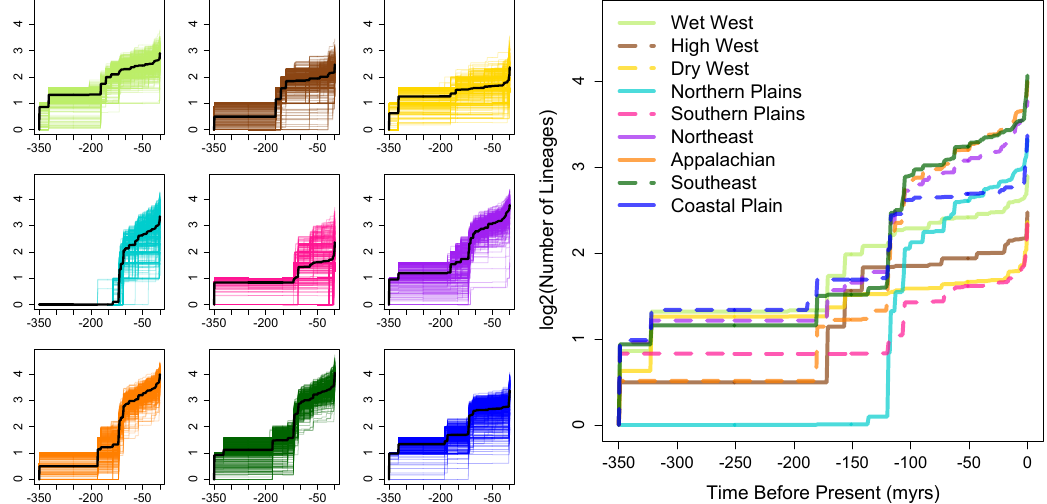
Figure 5. ( Left ) Lineage through time (LTT) plots for a sample of 500 assemblages from each evolutionary group, with each coloured line representing the average values over 100 rarefactions of the given assemblage to 50 individuals. Meanwhile, the thick black line gives the mean value at each evolutionary depth across all assemblages for a given evolutionary group. ( Right ) The mean number of lineages at each evolutionary depth across all assemblages in each group (thick black line from left panel), arrayed on one plot for direct comparison. Note log2 transformation of y-axes and that the number of lineages at the right-hand side of each graph represents the (mean) species richness of the